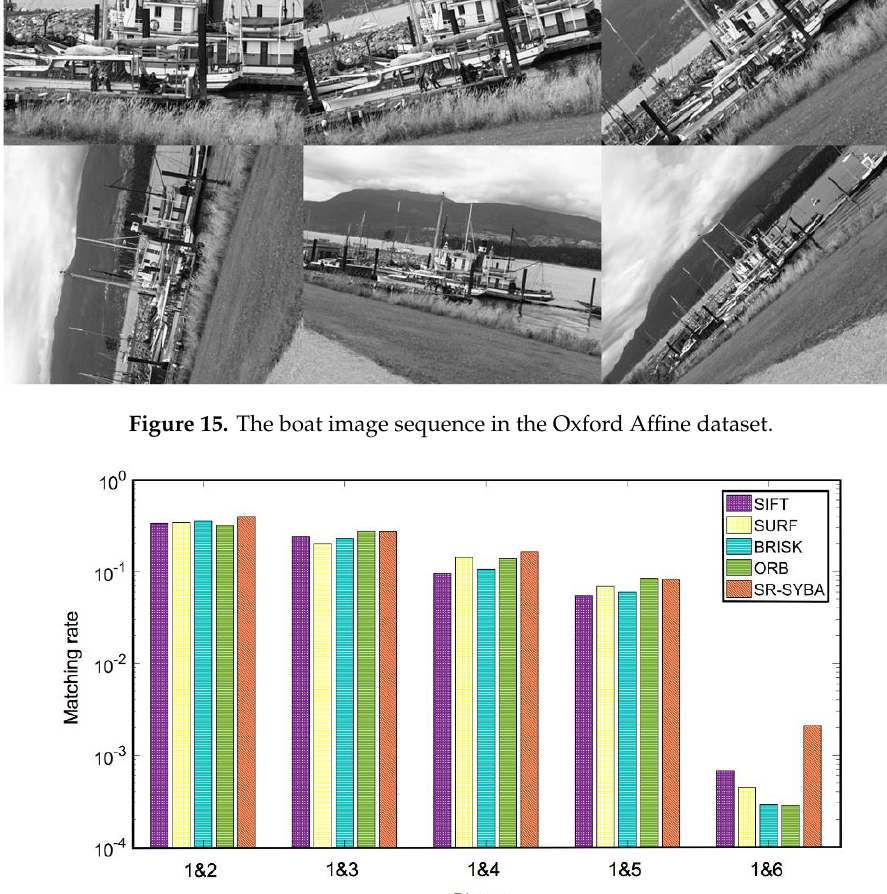
Figure 16. Matching rate comparison with the Boat image sequence.